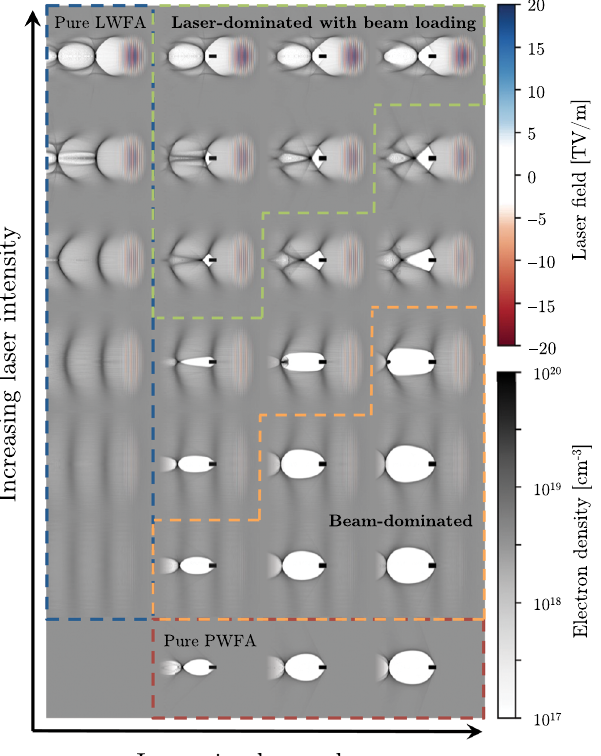
FIG. 1. Schematic view of the different regimes of laser- and beam-driven plasma wakefield acceleration studied in the scope of this work. These plots are based on quasi-3D particle-in-cell simulations, including the transitional regimes from beam-loaded laser wakefields to beam-dominated wakefields with a weaker laser contribution. The laser intensity is varied by changing the focal spot size of a 100-TW laser